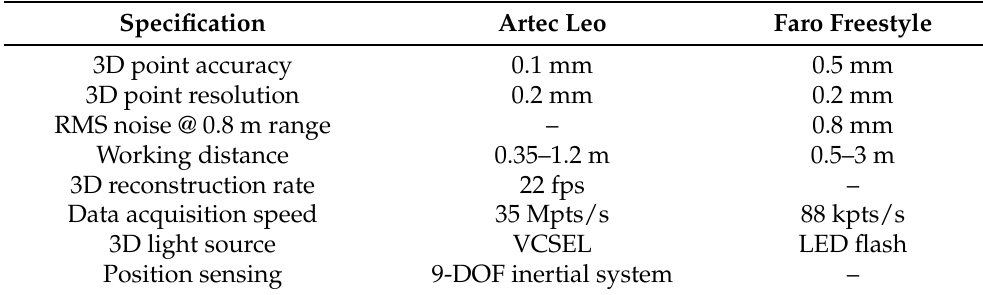
Table 6. Artec Leo and Faro Freestyle specifications as provided by the manufacturers. All informa- tion is not provided for both. RMS: root mean square; VCSEL: vertical cavity surface-emitting laser; LED: light-emitting diode; DOF: degree of